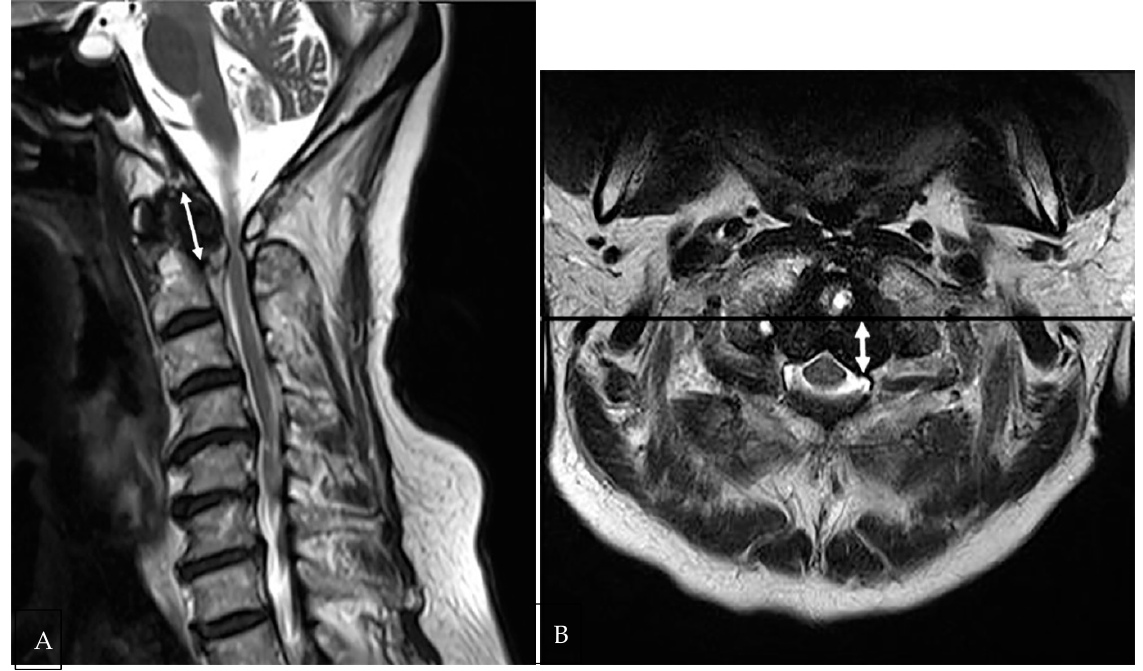
Figure 1. A 78 ‐ year ‐ old female patient with a non ‐ rheumatoid retro ‐ odontoid pseudotumor. ( A ) Mass ‐ like hypertrophy of retro ‐ odontoid soft tissue on a sagittal T2 ‐ weighted MR image. The long axis of soft ‐ tissue thickening (double ‐ pointed arrow) was obtained by measuring the longest length. Erosion of the odontoid process is noted. ( B ) The short ‐ axis of retro ‐ odontoid soft ‐ tissue hypertrophy (double ‐ pointed arrow) was measured from the posterior cortex of the odontoid process to the apex of the thickened soft tissue at the position where the soft ‐ tissue thickening was the most prominent in the axial T2WI.